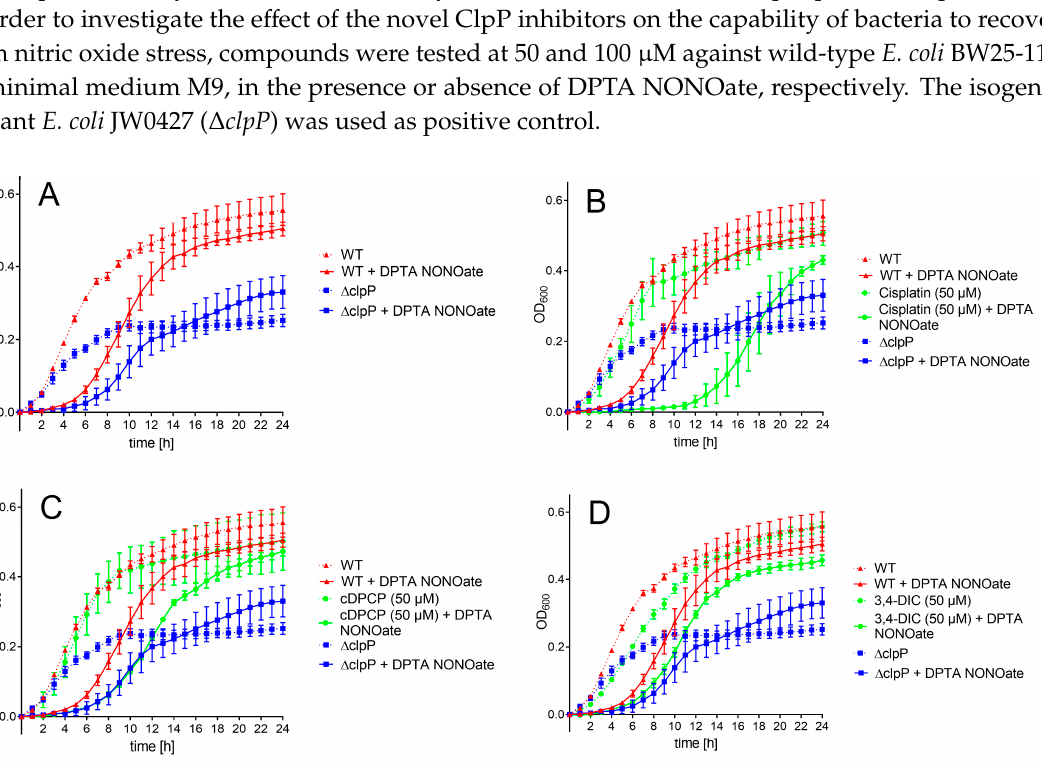
Figure 4. Bacterial growth curves of WT and ∆ clpP E. coli strains in minimal media and in presence (solid lines) and absence (dotted lines) of DTPA NONOate (NO • ). OD 600 was measured in absence ( A ) and presence of 50 µM ( B ) cisplatin ( C ) cDPCP and ( D ) 3,4-DIC. Each value represents the mean of three independent experiment ± standard deviation.